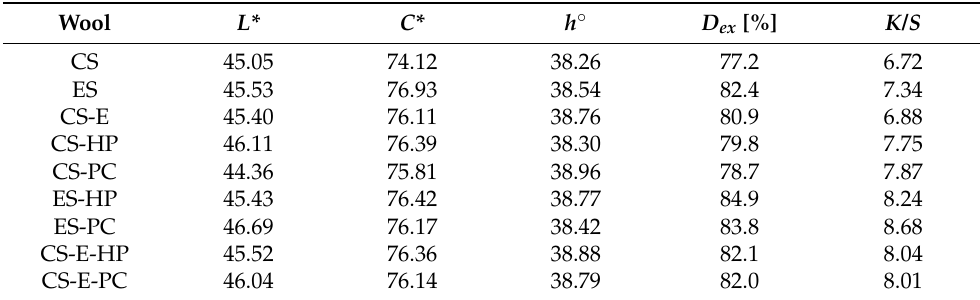
Table 5. Color parameters (L*, C*, h ◦ ), dye exhaustion ( D ex ) and color strength at 450 nm (K/S) of scoured and bleached wool fibers dyed with 3% owf Acid Red 111.